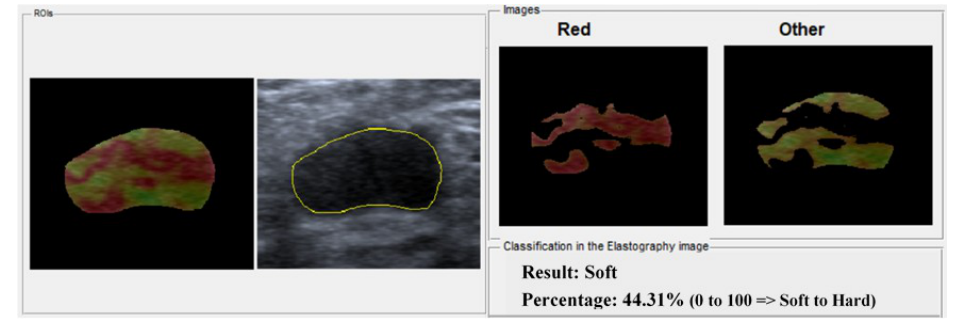
Figure 5. Classification using the system proposed.